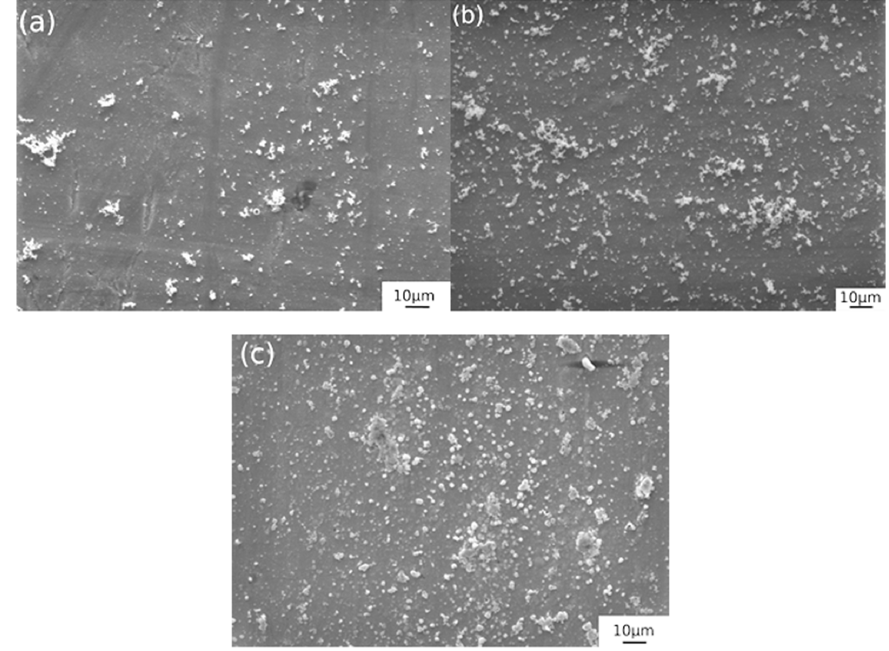
Figure 8. SEM images of the samples obtained with solution 2 at ambient temperature with different soaking times: ( a ) 30 min, ( b ) 60 min, ( c ) 100 min.